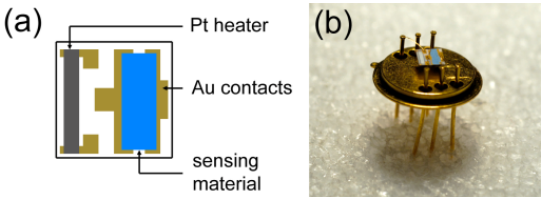
Figure 2. ( a ) Sketch of parallel sensor heater and contacts geometry on alumina substrate; ( b ) image of the sensor bonded in floating configuration on a TO8